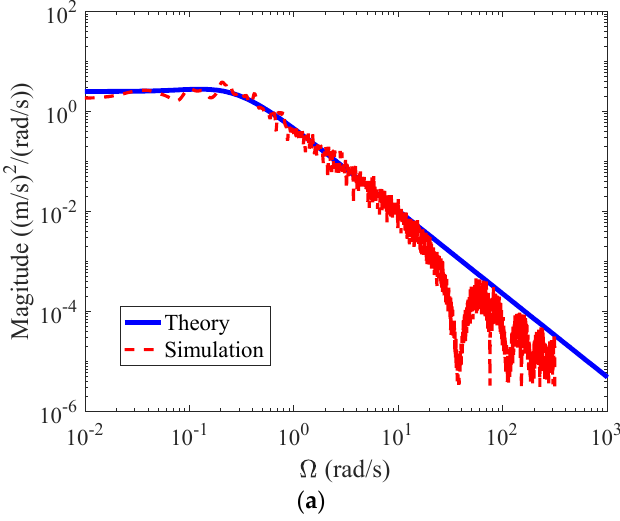
Figure 7. Comparison between simulated and theoretical spectra of vertical turbulence component at fuselage for flight over a city center.